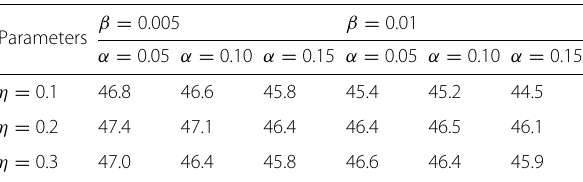
Table 3 Comparison results of the AUC score (%) on OTB50 dataset with different values of parameters α , β , and η β = Parameters